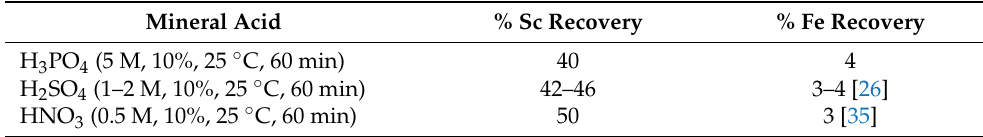
Table 6. Comparison of H 3 PO 4 efficiency with other mineral acids for selective Sc recovery under optimum condition in each case and one stage